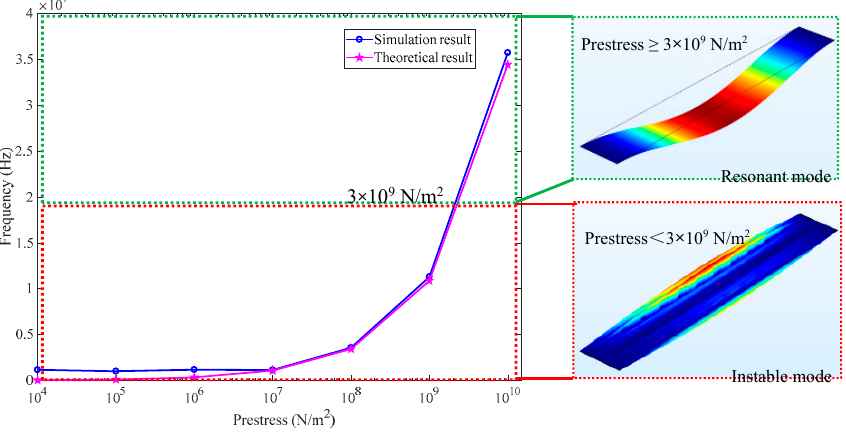
Figure 4. Prestress-induced resonance frequency change of graphene beam.